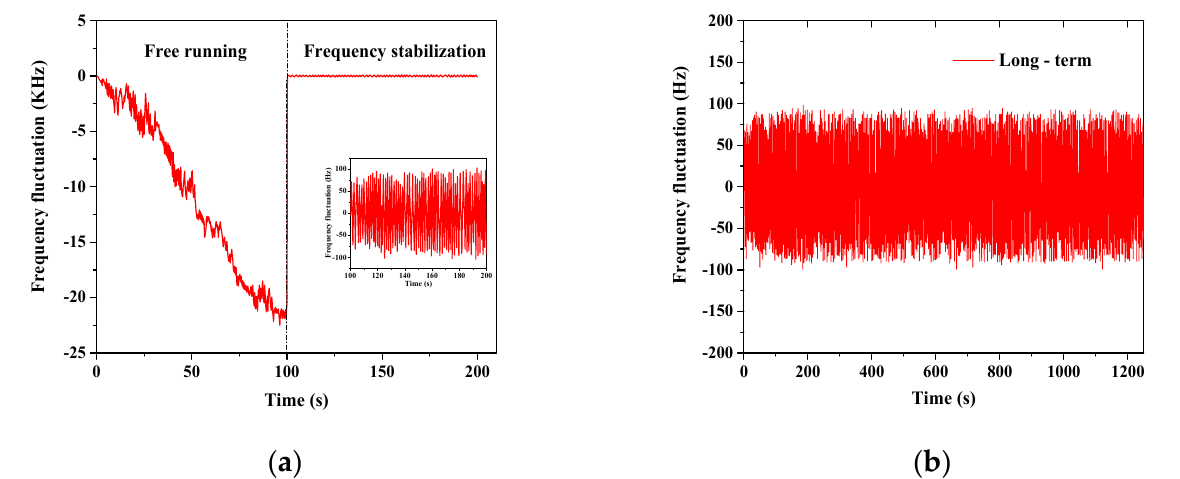
Figure 7. Frequency fluctuation diagrams of QML operation state: ( a ) short-term frequency fluctuation for the free running